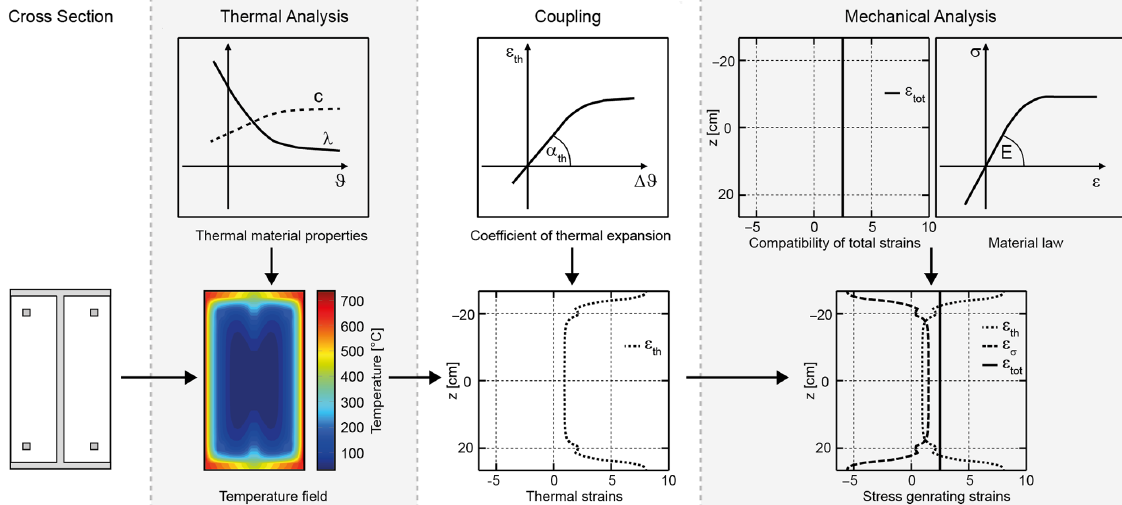
Fig. 1. Scheme for the approach of coupling the mechanical analysis with an upstream thermal